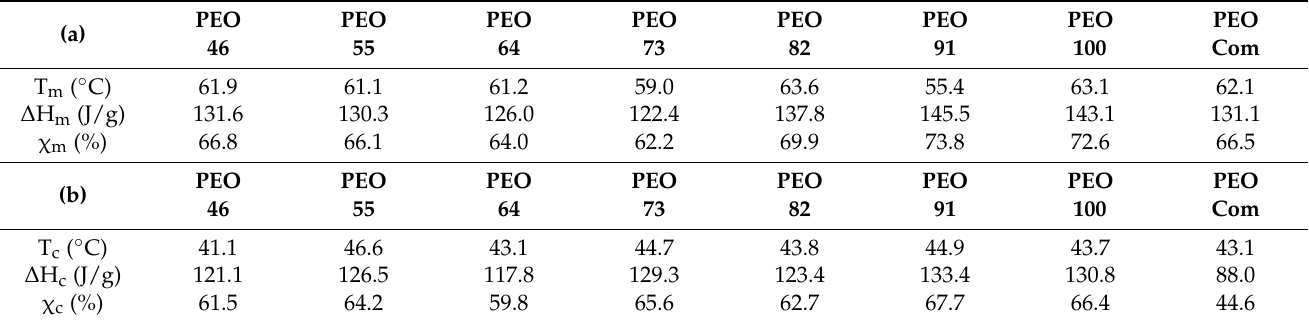
Table 3. Data obtained from DSC curves corresponding to: (a) melting transition and (b) crystallization process.